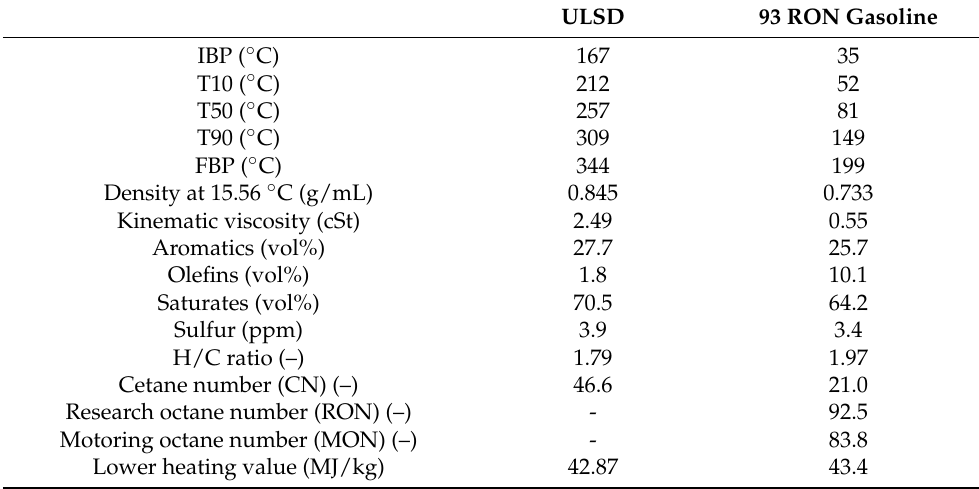
Table 1. Properties of test fuels (data from